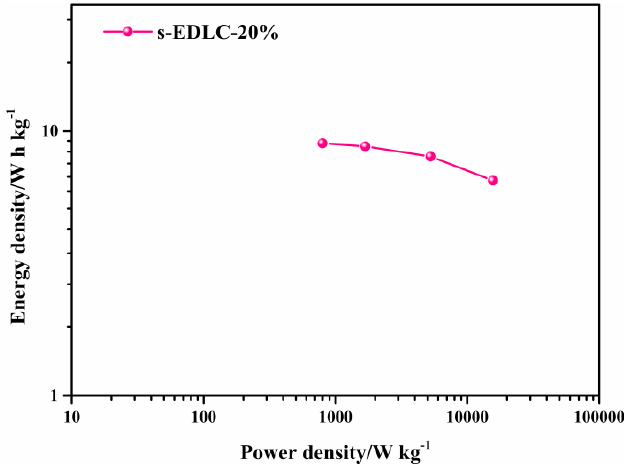
Figure 8. Ragone plot of solid-state supercapacitor